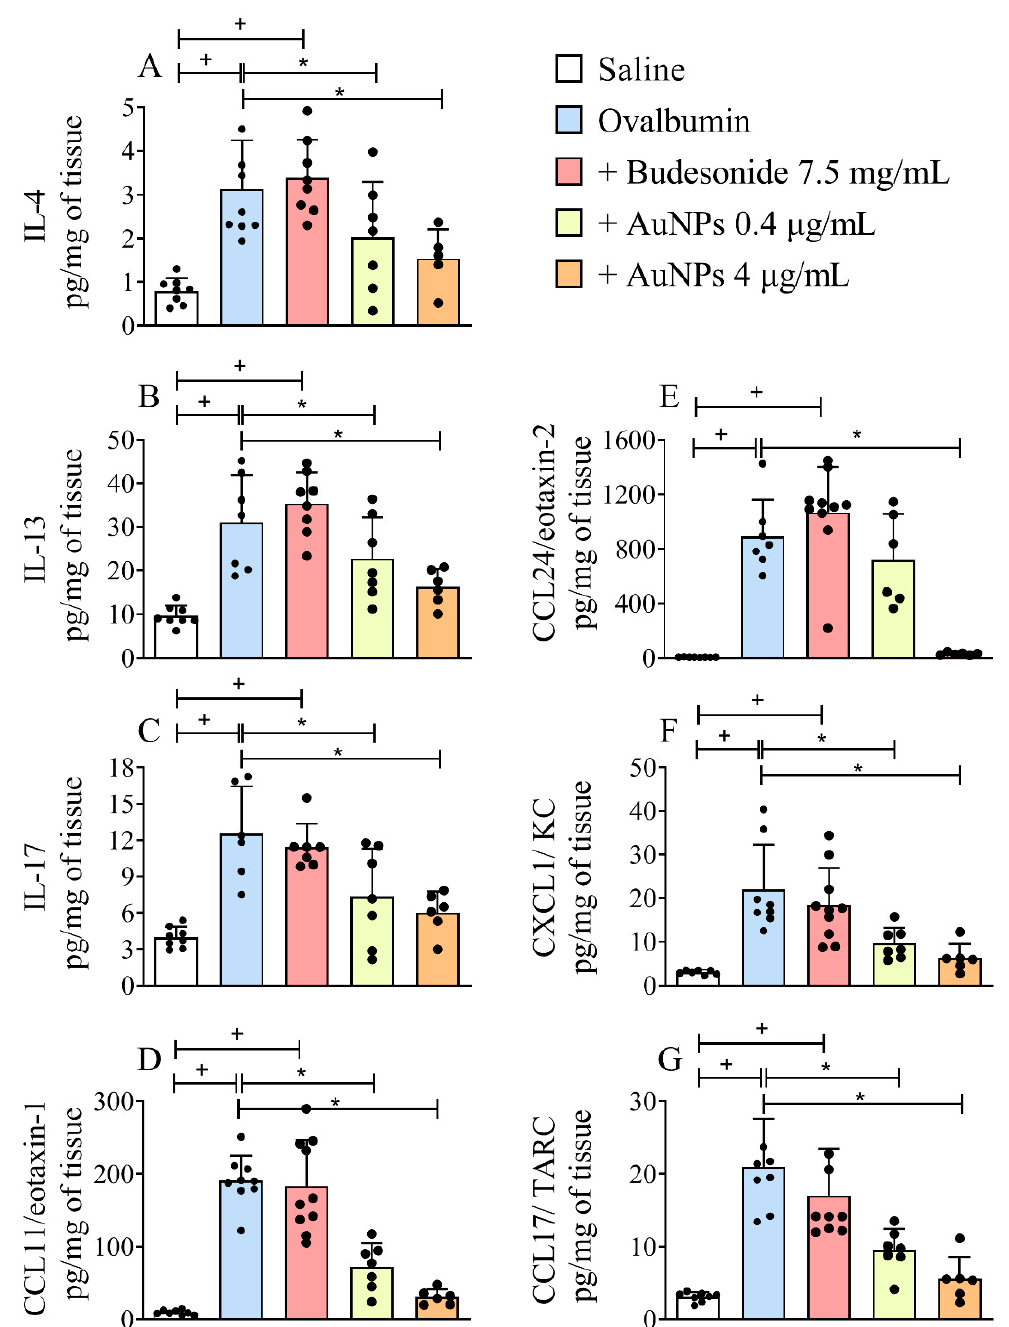
Figure 4. The effect of nebulized Budesonide or gold nanoparticles (AuNPs) on changes in cytokine and chemokine levels following ovalbumin intranasal instillation given once a week for 9 weeks. The levels of interleukin (IL)-4 ( A ), IL-13 ( B ), IL-17 ( C ), CCL11/eotaxin-1 ( D ), CCL24/eotaxin-2 ( E ), CXCL1/ keratinocyte chemoattractant (KC) ( F ) and CCL17/ thymus and activation regulated chemokine (TARC) ( G ) were measured by Enzyme-Linked Immunosorbent Assay (ELISA) in whole-lung homogenates. Data are expressed as mean ± SD (Each dot represents an individual mouse; n = 6 for all analyses, except IL-4 quantification under AuNP treatment, whose n is 5). + p ˂ 0.05 as compared with the saline group, * p ˂ 0.05 as compared with the ovalbumin-challenged group.